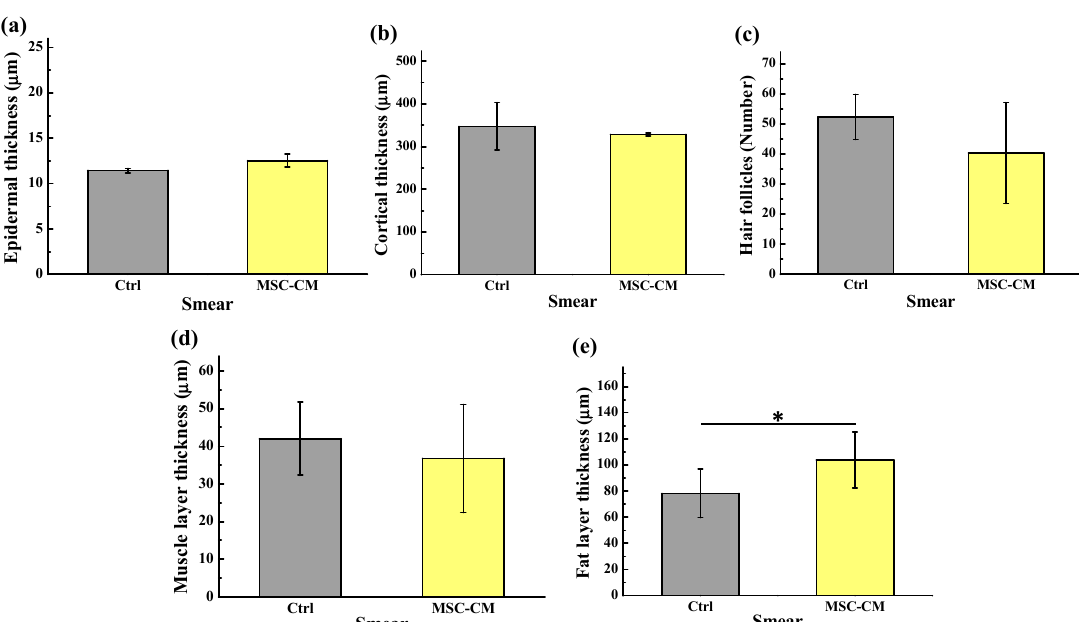
Figure 7. Quantitative evaluation showing the thickness of various skin layers after being treated with MSC-CM: ( a ) epidermal thickness, ( b ) cortical thickness, ( c ) hair follicles number, ( d ) muscle layer thickness, and ( e ) fat layer thickness (* p < 0.05).